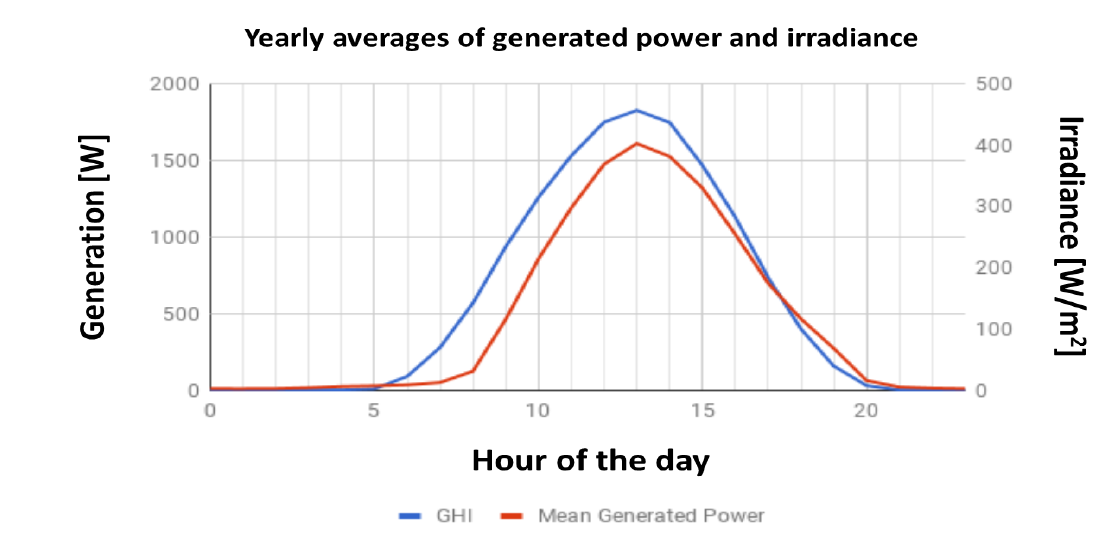
Figure 5. Generated power and irradiation on a yearly basis given in 24 hours per